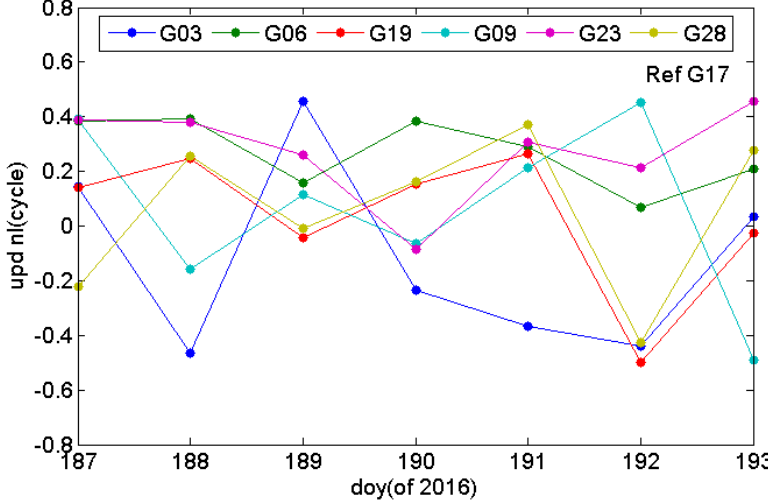
Table 1. Wide-lane uncalibrated phase delay STD of the GPS satellite between the 187th and the 206th day of 2016.